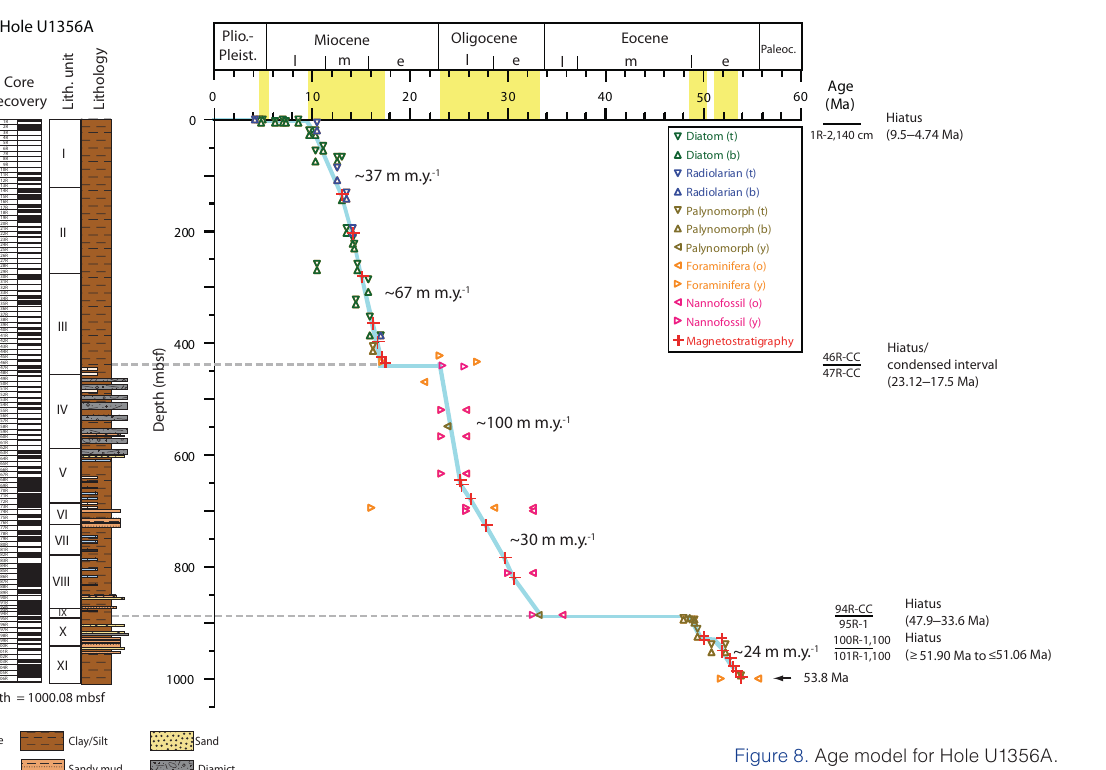
Figure 8. Age model for Hole